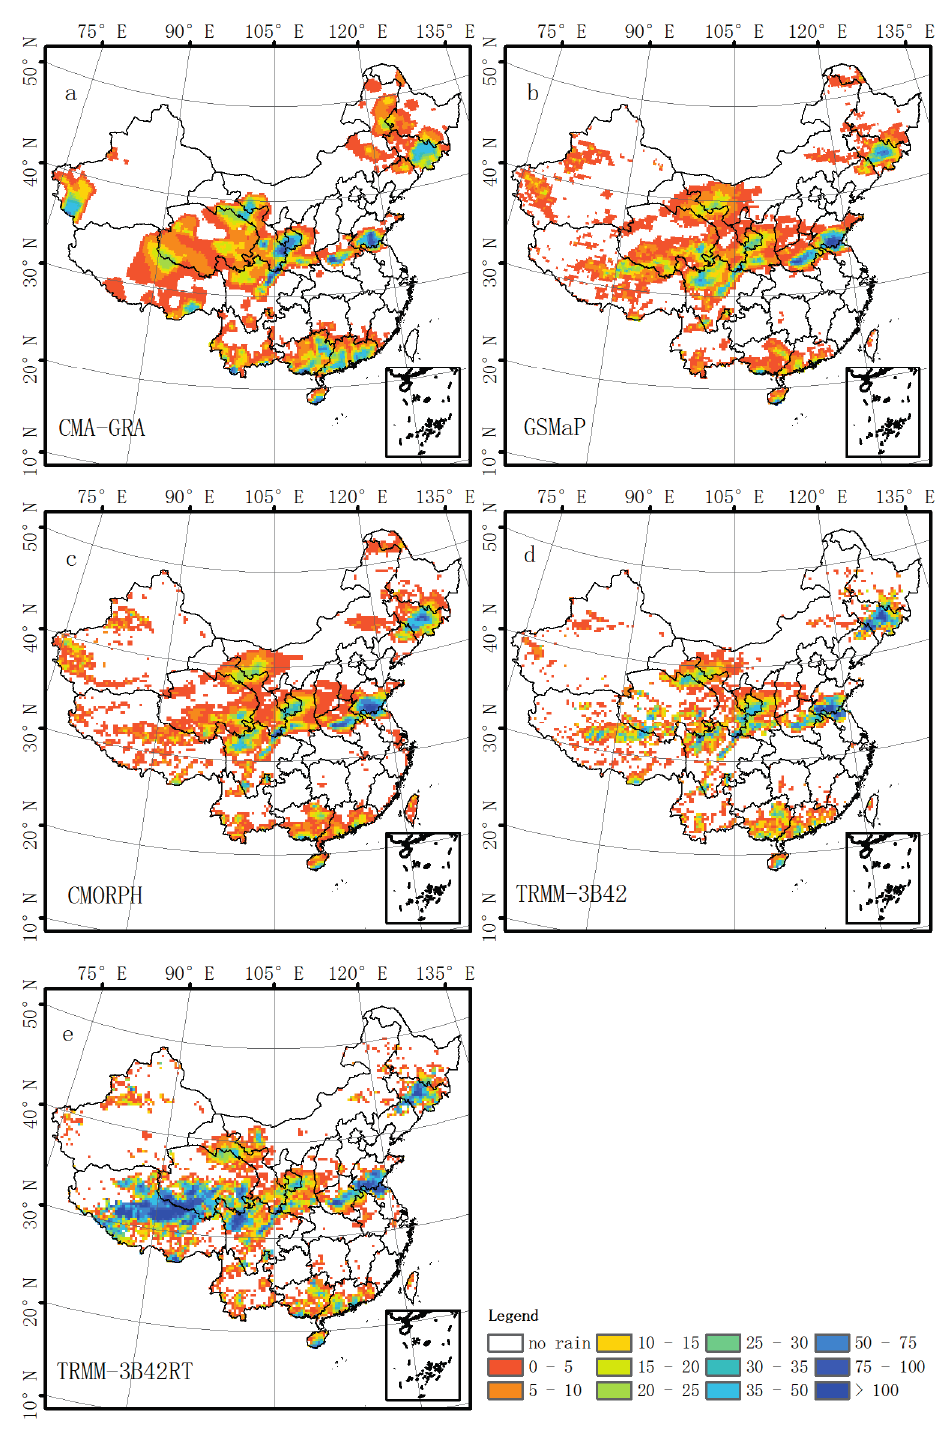
Figure 5. Snapshots of daily precipitation patterns on an arbitrary summer day (1 July 2005) for ( a ) CMA, ( b ) GSMaP, ( c ) CMORPH, ( d ) TRMM 3B42 and ( e ) TRMM 3B42RT. Units are